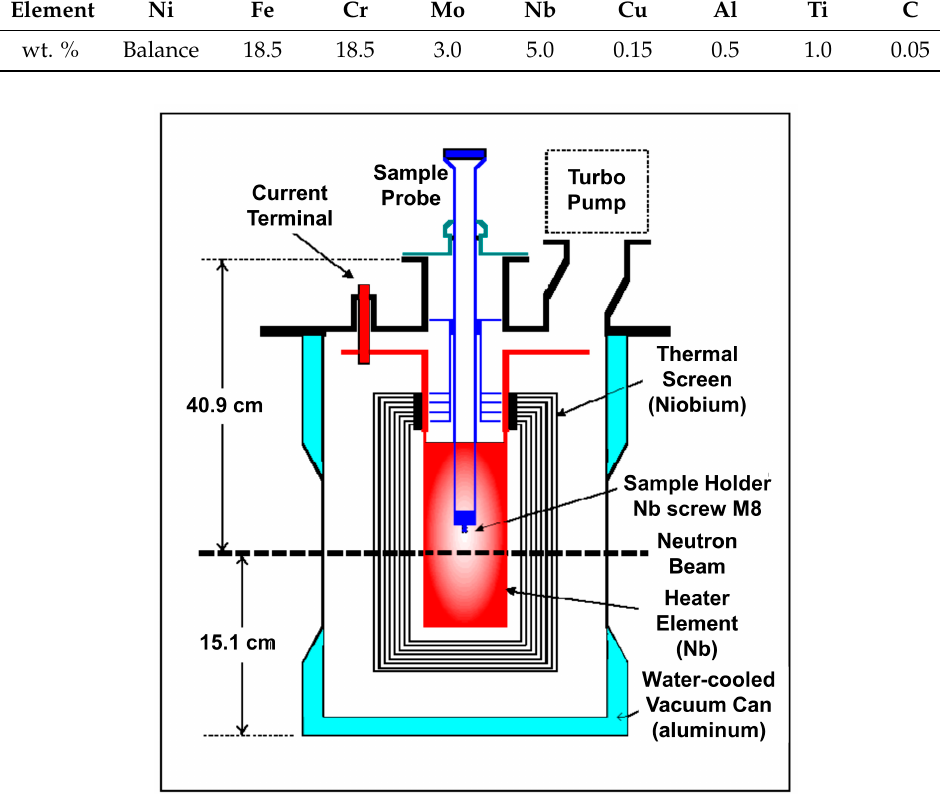
Figure 1. A layout of the VULCAN furnace.